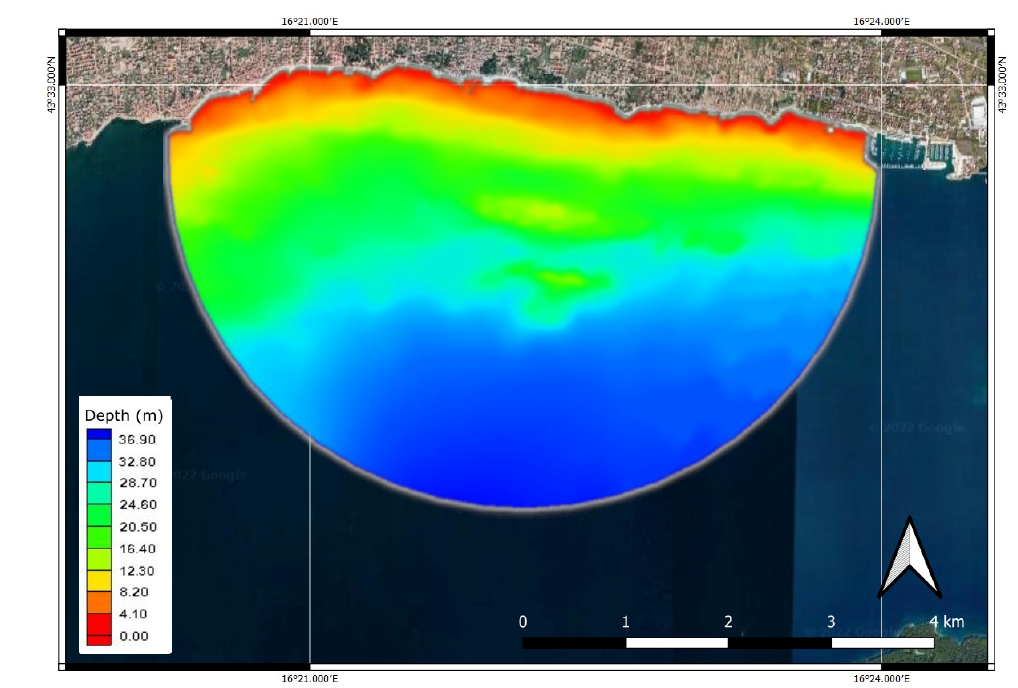
Figure 4. Bathymetric features at the location of interest.